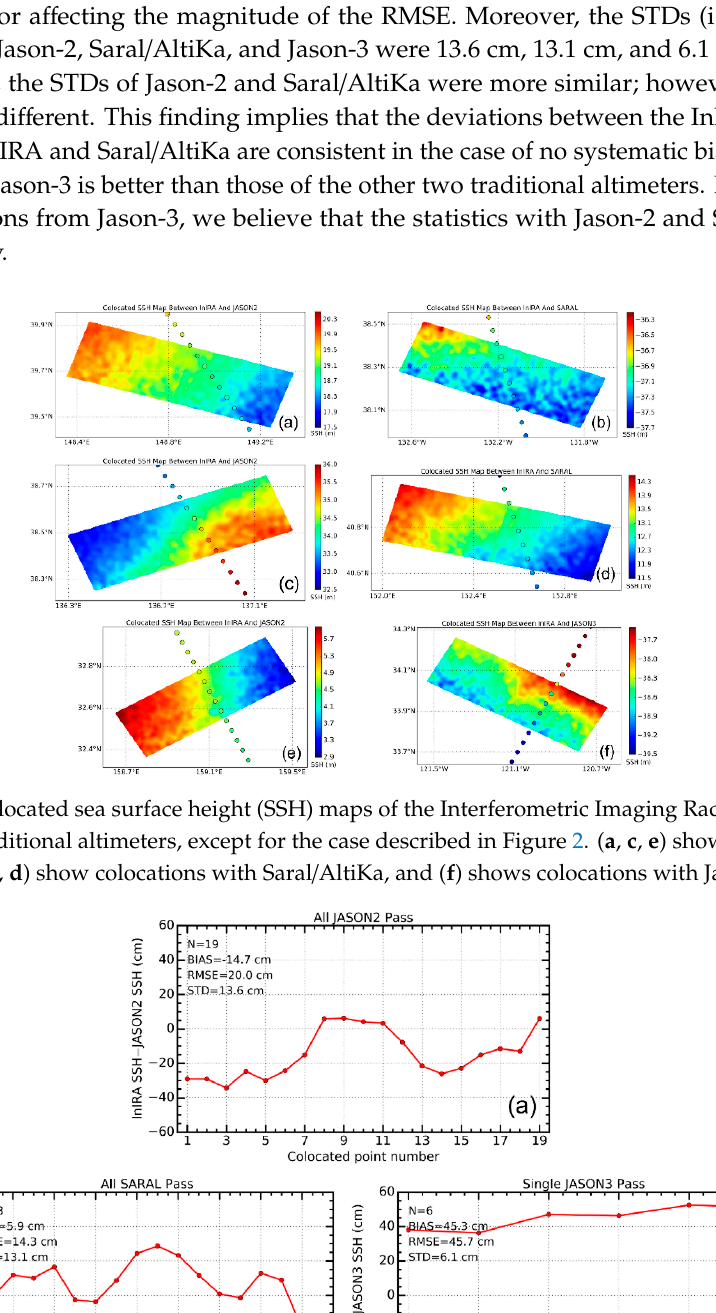
Figure 4. Sea surface height ( SSH) comparisons between the Interferometric Imaging Radar Altimeter (InIRA) and each type of traditional altimeter, ( a ) for all Jason-2 passes, ( b ) for all Saral/AltiKa passes, and ( c ) for a single Jason-3 pass.